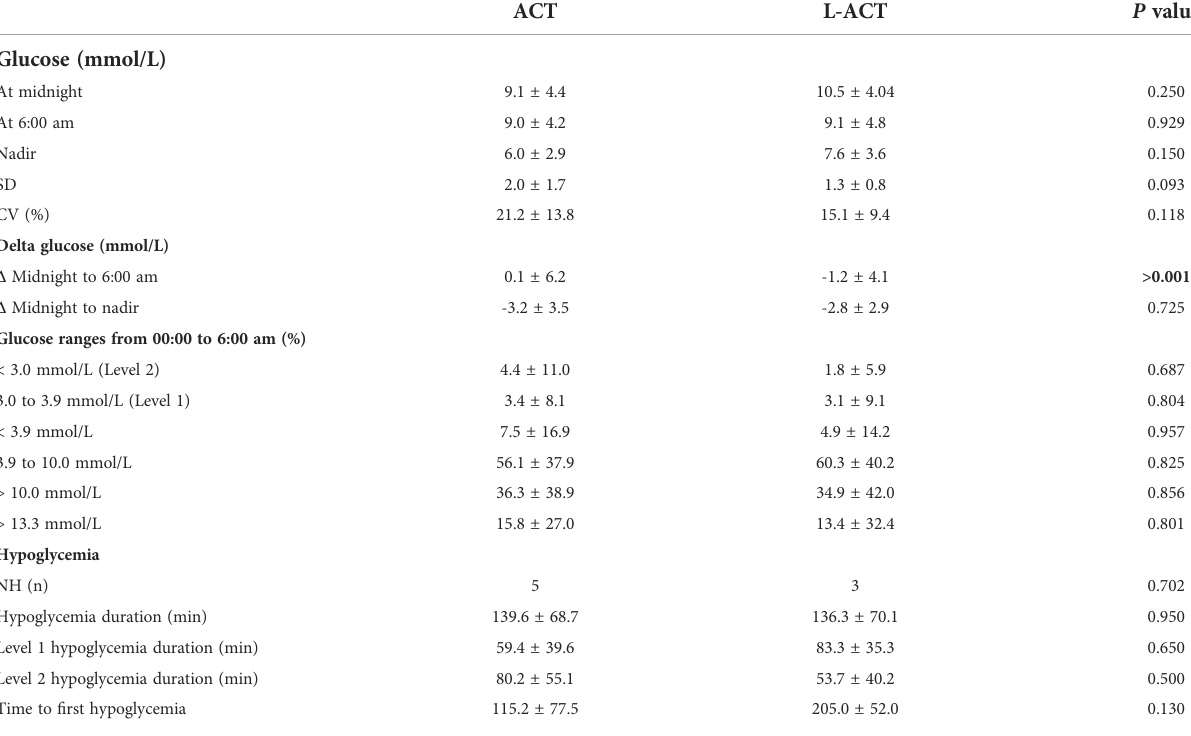
TABLE 3 Nocturnal glucose and nocturnal hypoglycemia outcomes based on intersitial glucose measurements. ACT L-ACT P